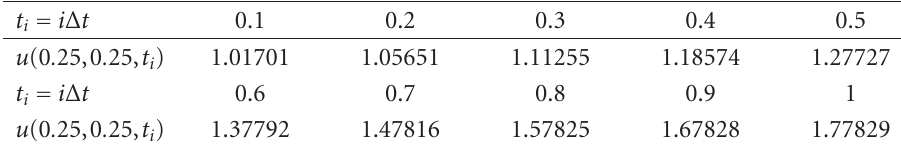
Table 4.1. Overposed exact matching data for u in t i and location (0 . 25,0 .